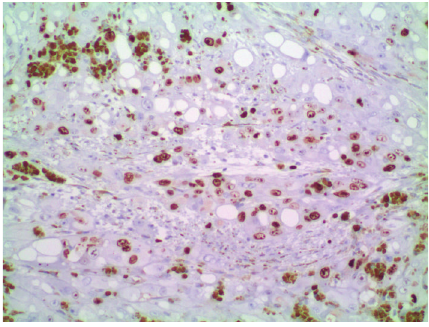
Figure 6: Area of angiosarcoma with extensive Ki67